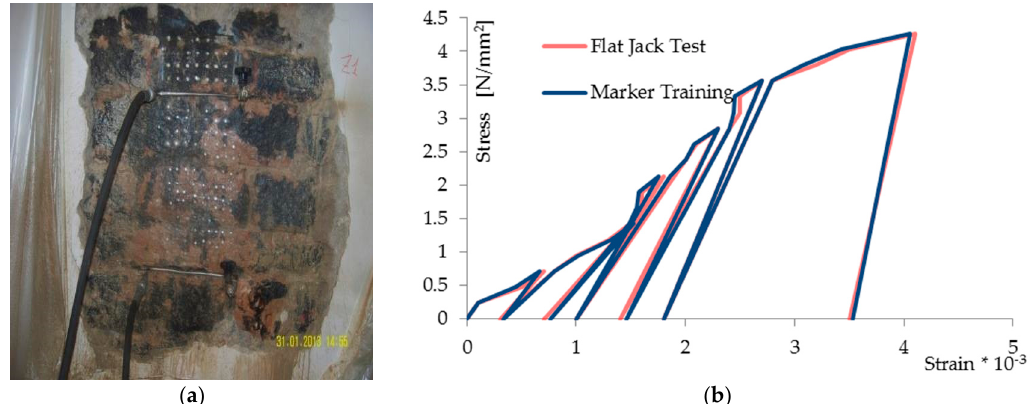
Figure 10. ( a ) Palazzo Silvi: wall prepared for the Flat Jacks and Marker Tracking tests. ( b ) The stress ‐ strain diagrams obtained from the cyclic load test for the two techniques.